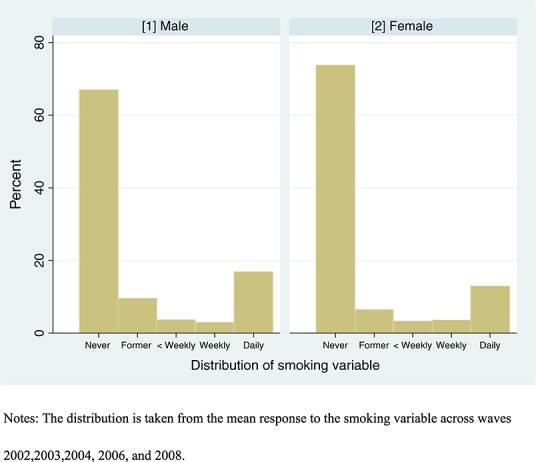
Distribution of the smoking variable for young adults separated by gender